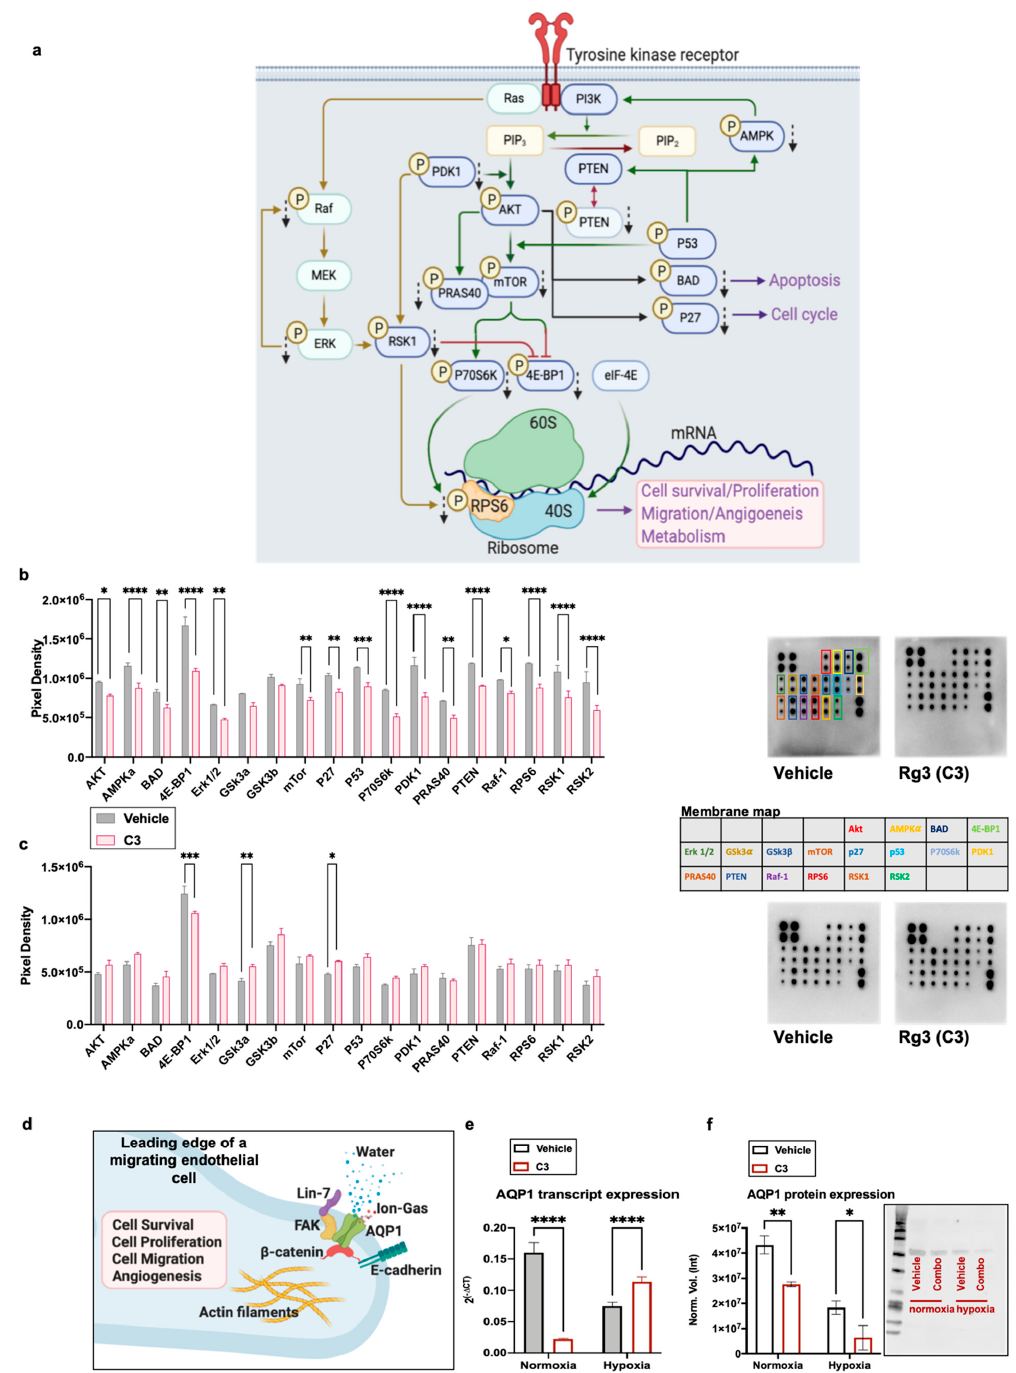
Figure 5. ( a ) A schematic diagram of the signaling of the downstream activation of a receptor tyrosine kinase, leading to cell survival, proliferation, migration, angiogenesis, and metabolism (created with BioRender.com (accessed on 11 March 2021)). The effects of C3 (50 µM SRg3 + 25 µM RRg3) on the phosphorylation of signaling proteins in PI3K/AKT signaling in HUVEC cells grown in ( b ) normoxia and ( c ) hypoxia (1% O 2 ) conditions. The cells were exposed with C3 for three days. The data show the mean ± SD of two replicates with p < 0.05. ( d ) A schematic diagram of the role of AQP1 localised in the leading edge of an endothelial cell facilitating cell migration (reviewed in [9]) (created with BioRender.com). The cells were exposed with C3 for thee days in normoxic or hypoxic (1% O 2 ) conditions. Expression levels of ( e ) AQP1 transcripts measured with QT-PCR or ( f ) proteins detected using the Western blotting technique in normoxic and hypoxic conditions are shown. The data represent the mean ± SD of three replicates with p < 0.05. * p < 0.05, ** p < 0.01, *** p < 0.001 and **** p <